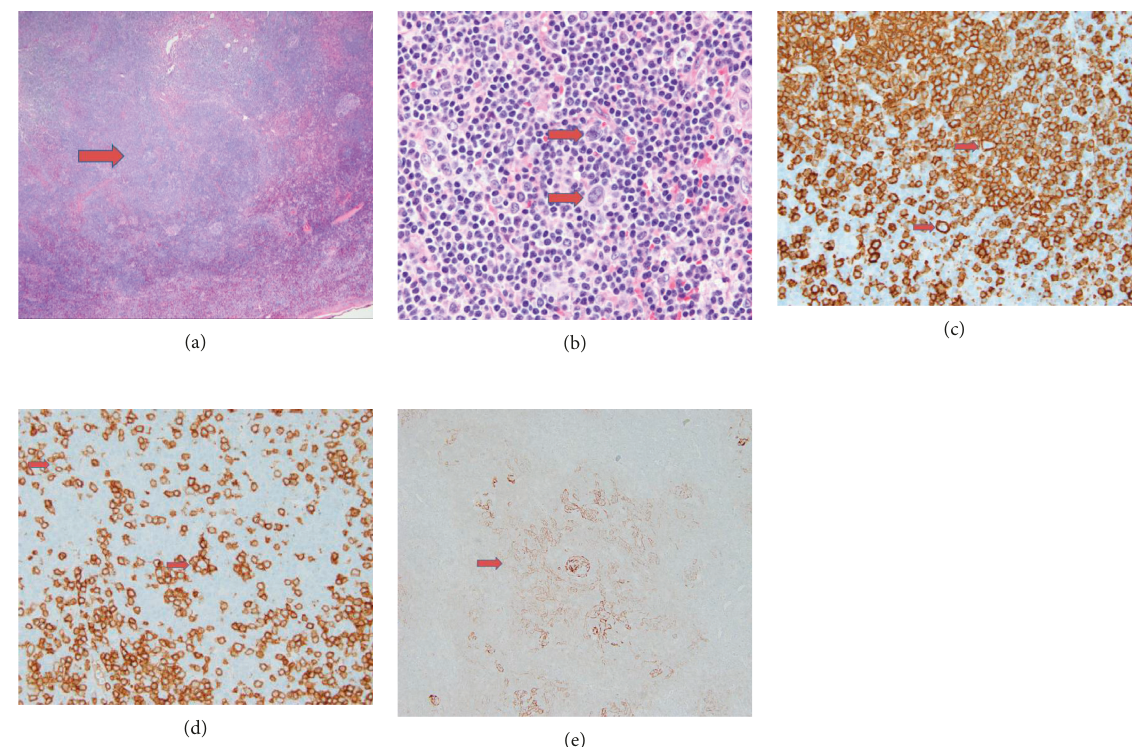
Figure 1: (a) Low-power H&E staining showing prominent nodules in the background of reactive lymphoid tissue. (b) Interspersed large “popcorn” lymphocyte-predominant cells. (c) Large popcorn cells are positive for CD20. (d) CD3-positive T cells form rosettes around the large popcorn cells. (e) CD21 staining showing expanded follicular dendritic network in the large